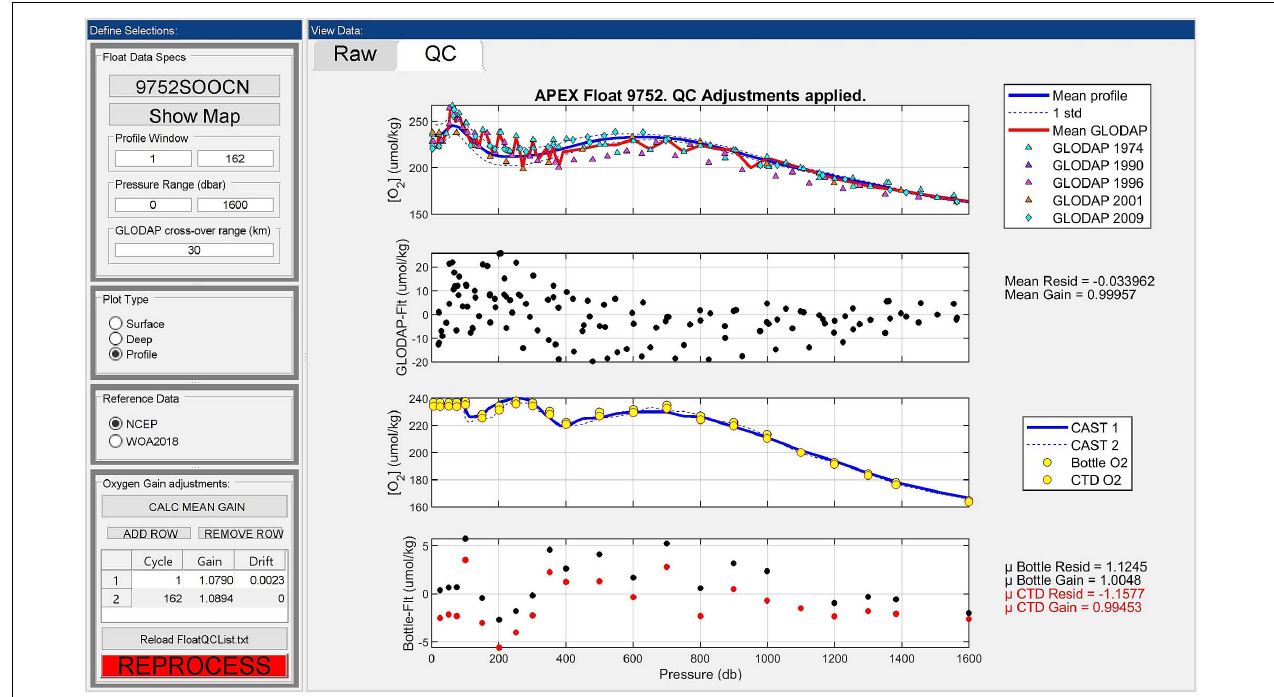
FIGURE 4 | A comparison of adjusted oxygen data to GLODAPv2 (top two panels) and shipboard hydrocast matchups (lower two panels), as viewed through the SAGE-O 2 interface for UW/MBARI float 9752 (WMO